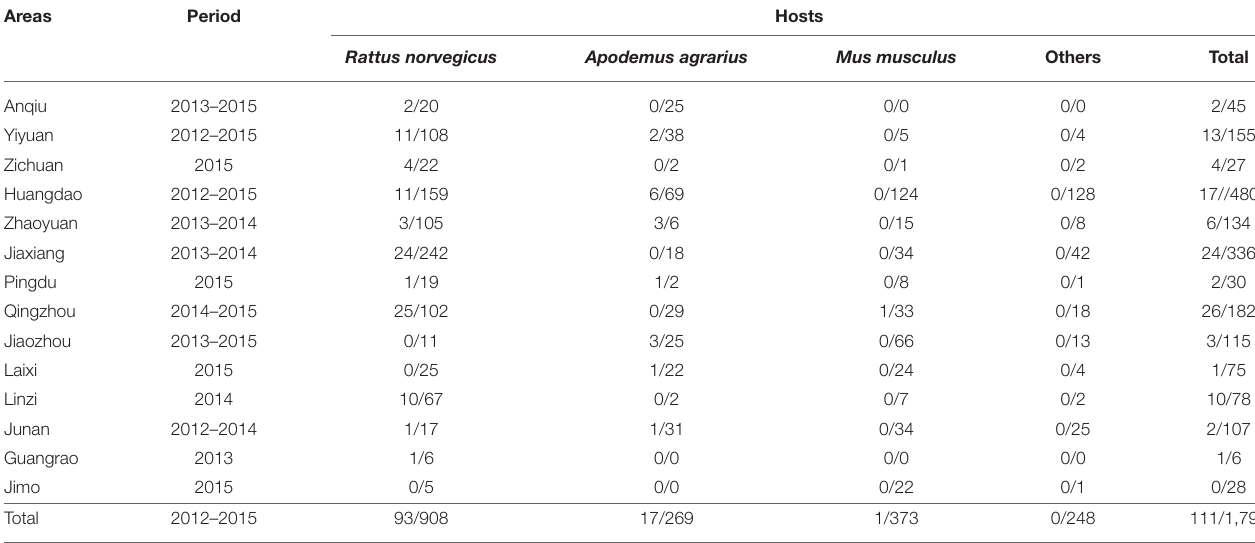
TABLE 2 | RT-PCR detection of hantaviruses RNAs in rodents of Shandong Province. Areas